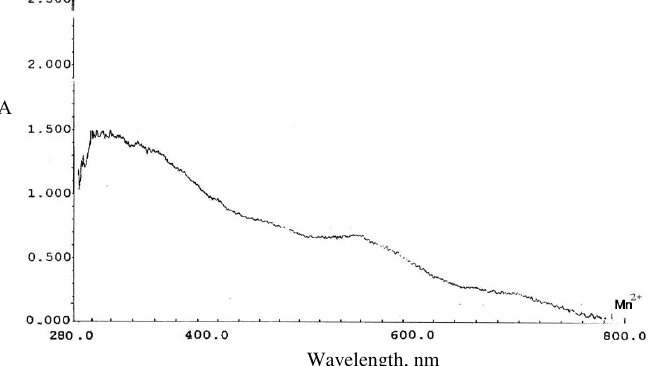
Figure 3. Electronic spectrum of Mn(II)-L 1 L 2 mixed ligand complex Electron paramagnetic resonance